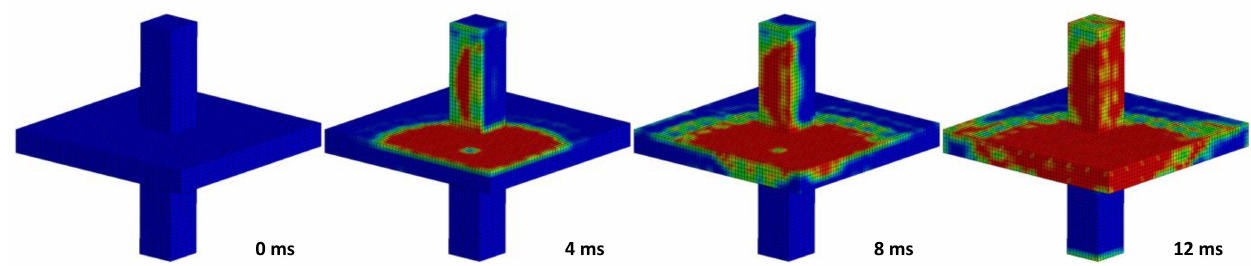
Figure 4. Typical forms of pressure